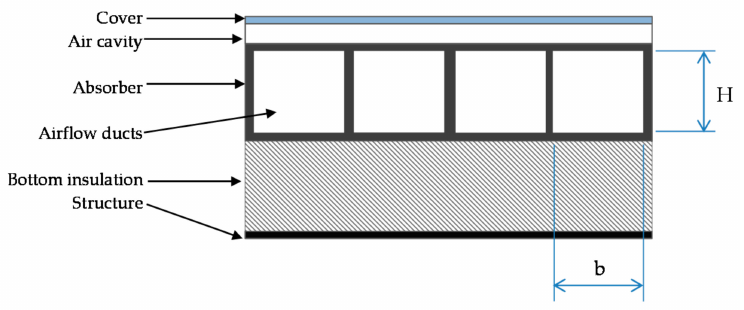
Figure 1. Schematic cross-section of the SAH.